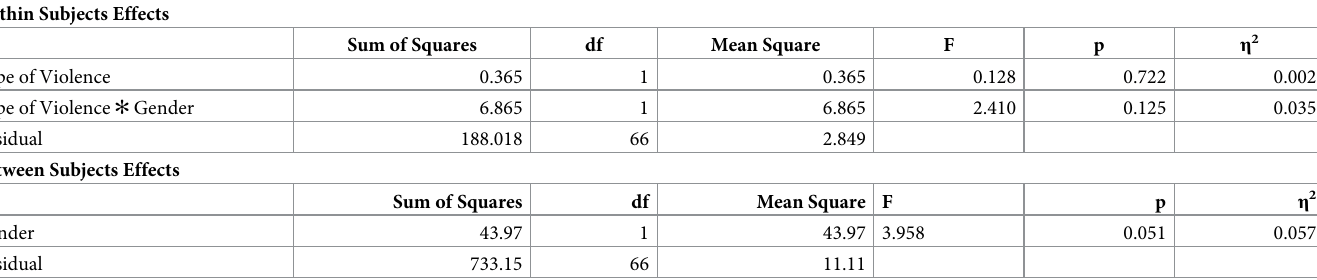
Table 1. ANOVA tables for narrator ratings by type of violence, Phase